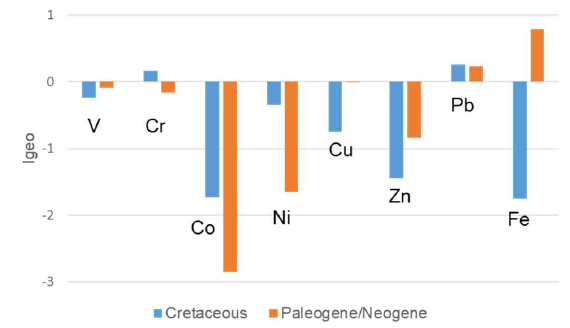
Figure 5. Plot of the average geoaccumulation index (I geo ) for trace elements in the Cretaceous and Paleogene / Neogene geophagic kaolinitic clays within Eastern Dahomey and Niger Delta Basins, Nigeria.